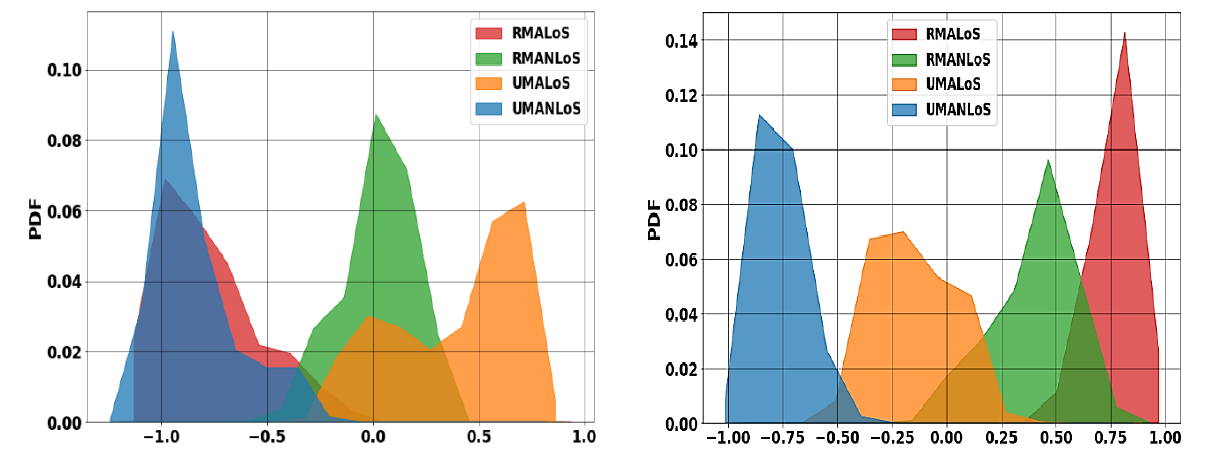
Figure 6. PDF of k-PCA output components.